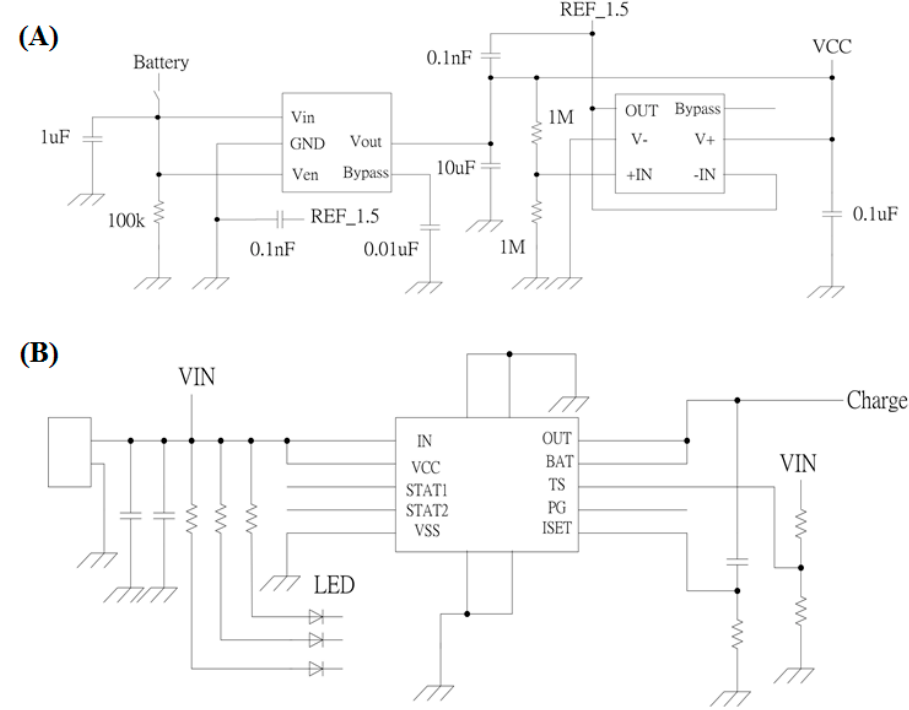
Figure 3. ( A ) Power supply circuit and ( B ) charging circuit in the electroencephalography (EEG) signal acquisition system.